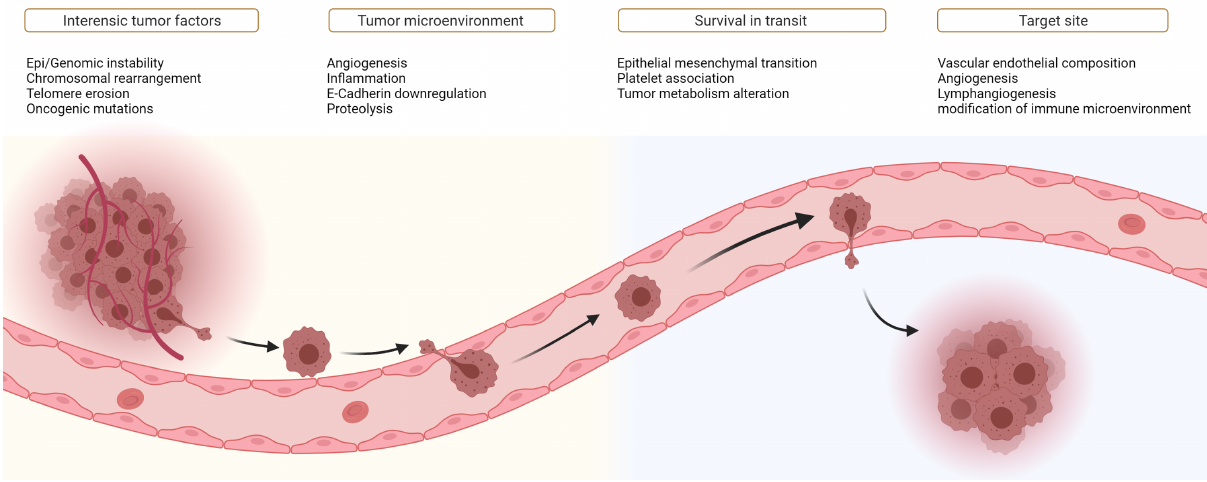
Figure 3. Factors that influence metastatic